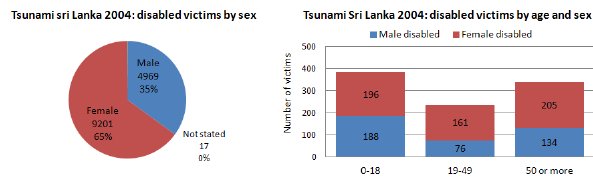
Figure 8. Tsunami disabled victims by age and sex (Sri Lanka tsunami 2004).